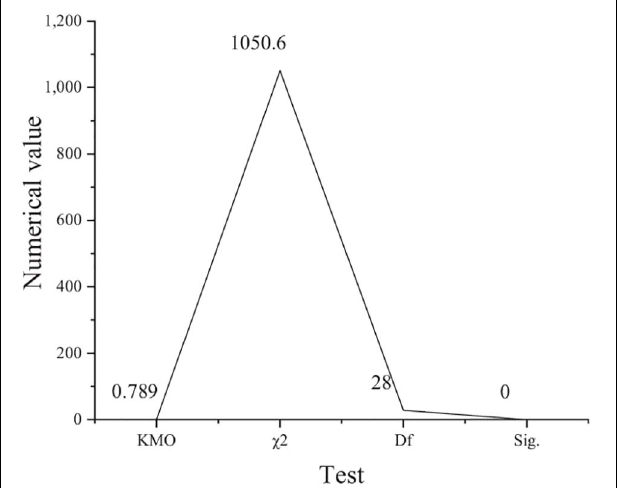
FIGURE 2 | Analysis results of entrepreneurial passion model ( χ 2 : approximate chi square; Df: degree of freedom; Sig: Significance